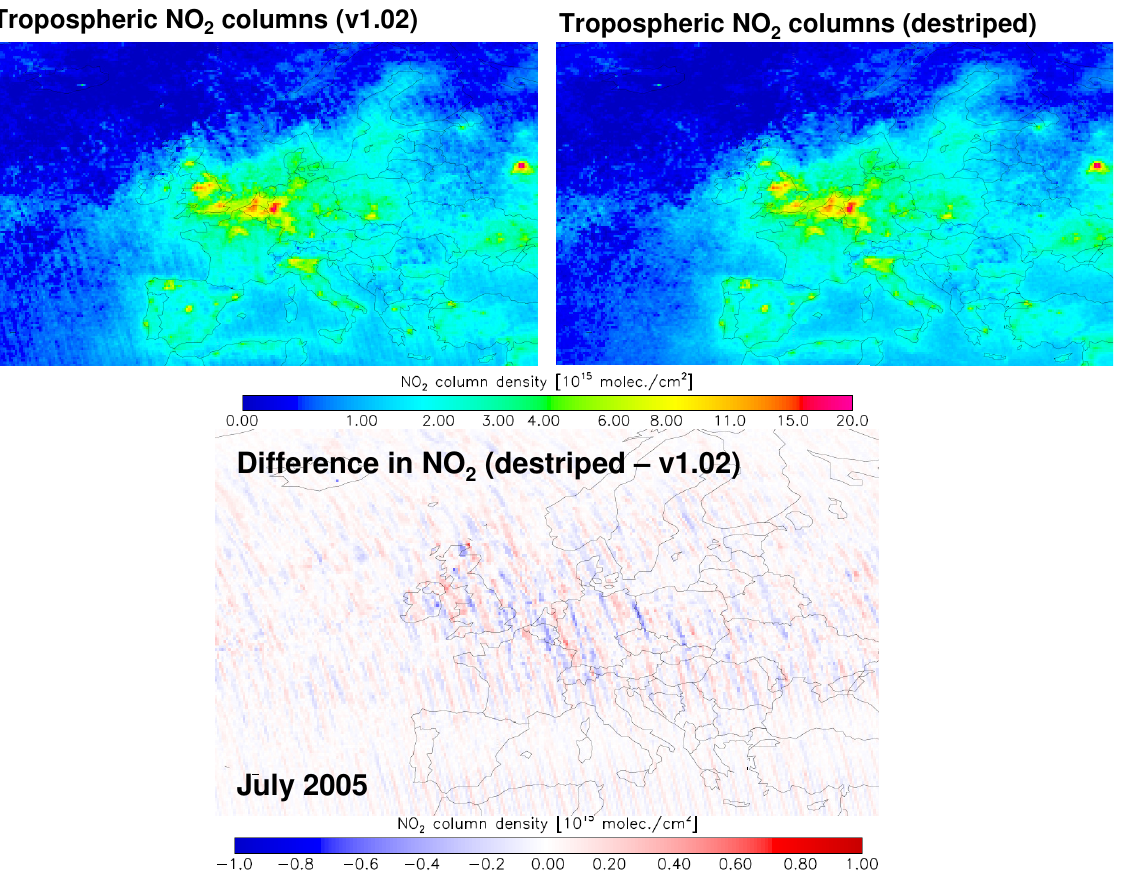
Fig. 9. Monthly mean OMI tropospheric NO 2 columns (July 2005) for v1.02 (left panel), after correction for the stripes (middle panel), and differences between destriped and original (v1.02) monthly mean OMI tropospheric columns (right panel). Cloudy scenes (cloud radiance fractions > 0.5) have been omitted in calculating the monthly mean.